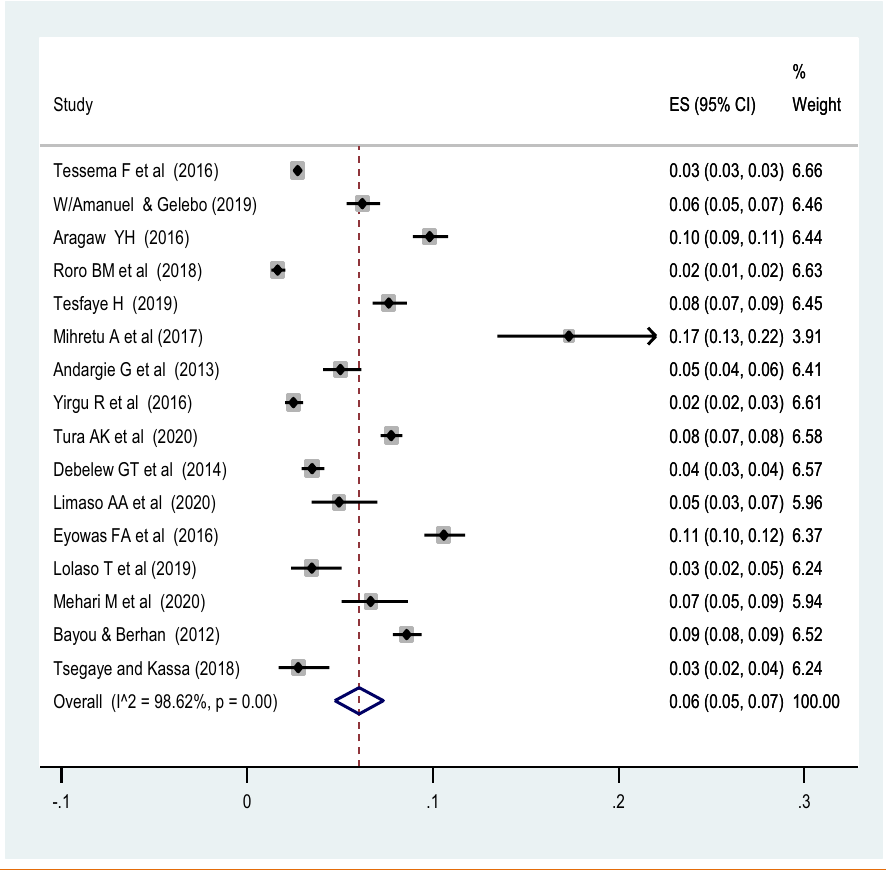
Figure 2. Forest plot on the pooled prevalence of perinatal mortality in Ethiopia: